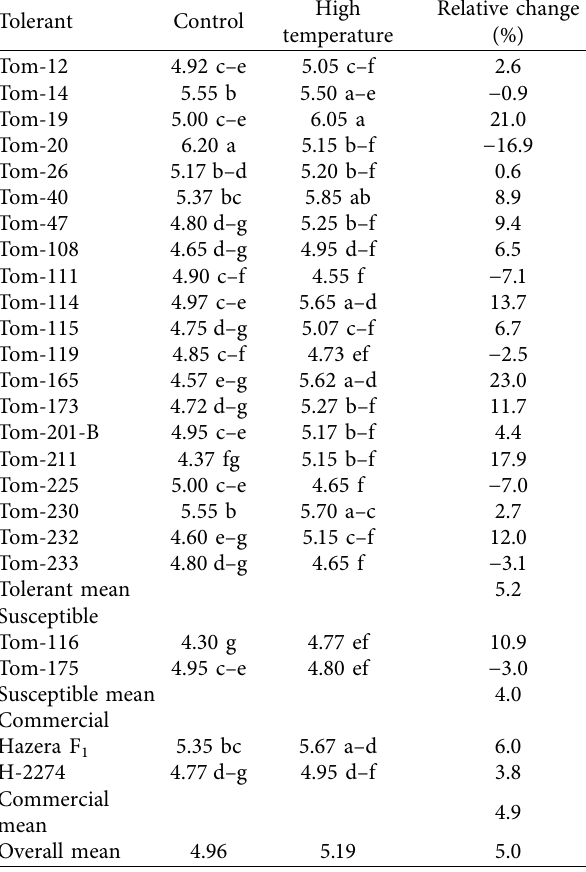
Table 3: Total soluble solids (Brix) of tomato fruits in control and high-temperature stress (%).